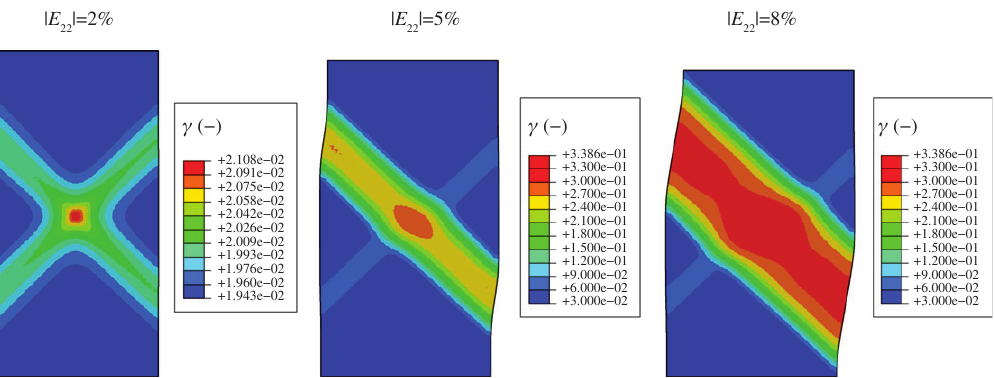
Figure 6 Sample S , general model behavior: spatial distribution of plastic strain γ at three applied compression strains | E 1